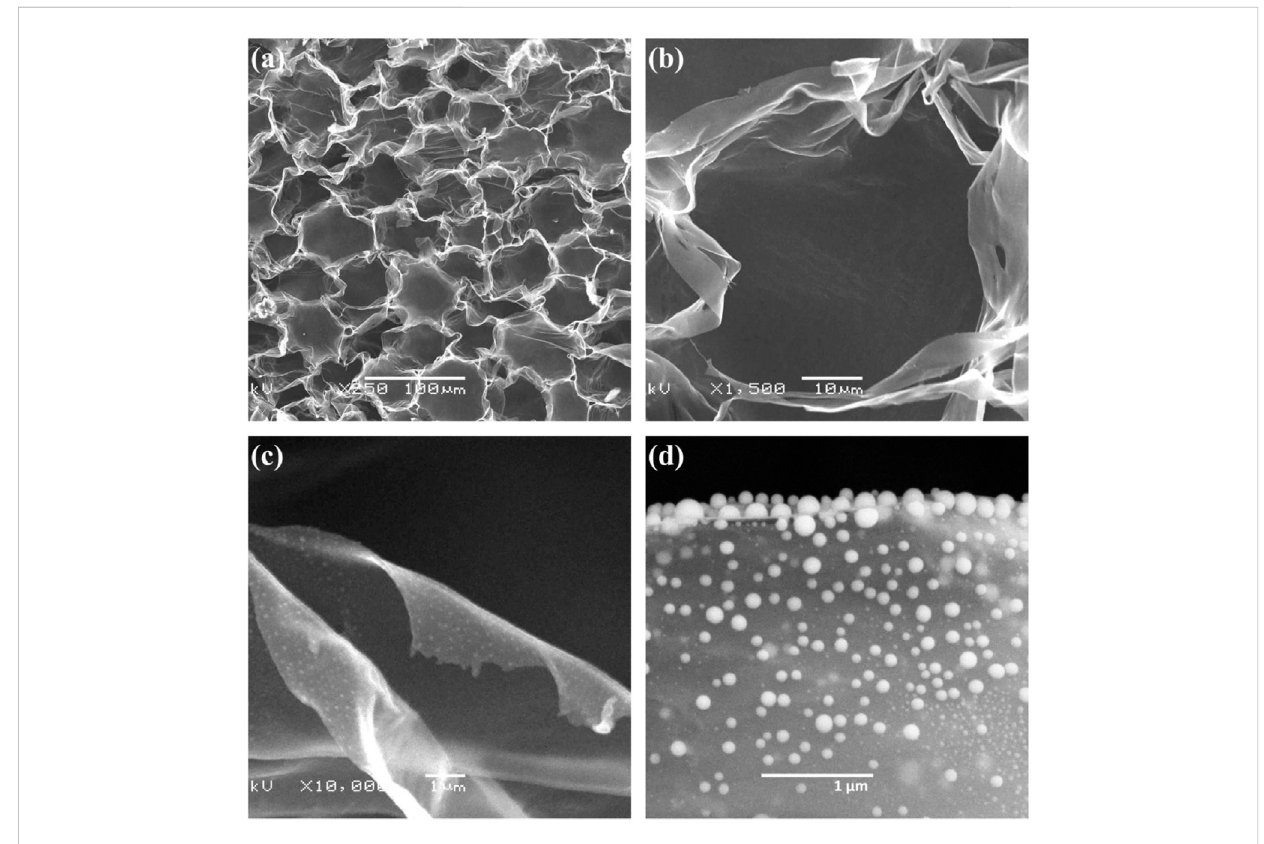
FIGURE 8 (A – D) SEM images of CHP/S at different magni fi cations (Wang, et al.,